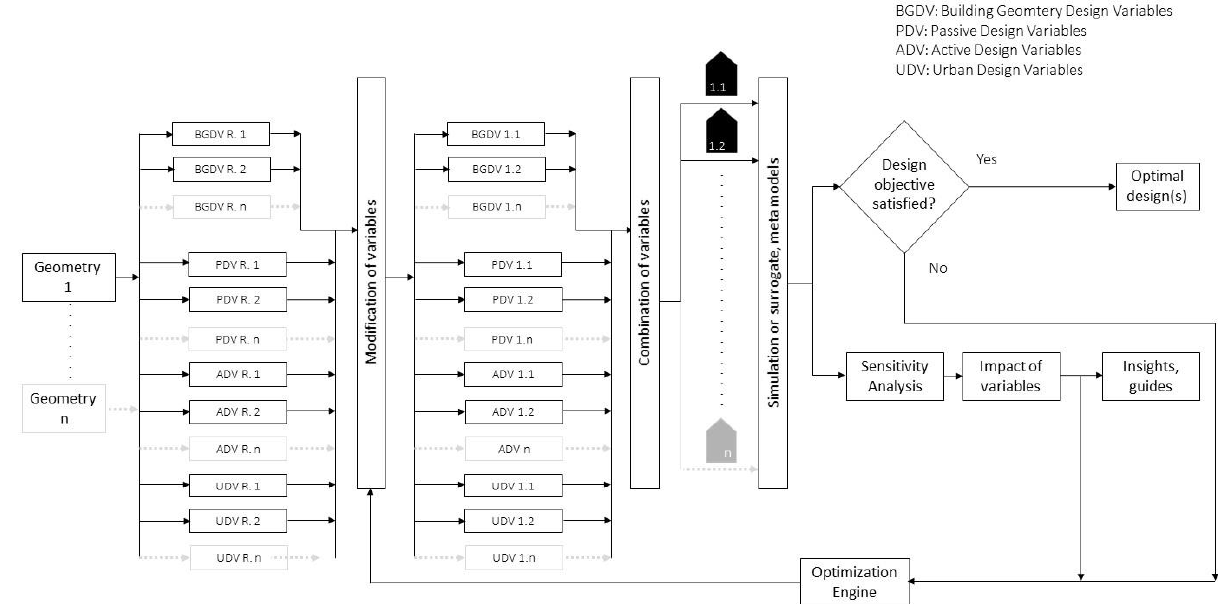
Figure 4. Flowchart showing the basic principles of building shape modification methodology in BECEDO processes.